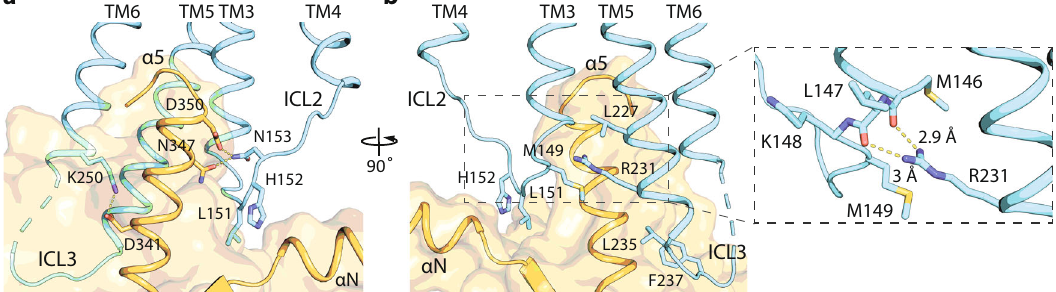
Fig. 7 Interactions between ICL2 of S1P 1 and G α i . a L151 in ICL2 is inserted into the hydrophobic pocket at the end of the N-terminal helix of G α i , and N153 forms hydrogen bonds with D350 and N347 from the α 5 helix of G α i . b L235 and F237 in ICL3 contact the hydrophobic surface of G α i , and K250 forms a salt bridge with D341 from the α 5 helix of G α i . R321 located at TM5 stretches to the amino-end of TM3 helix and interacts with the carbonyl backbone through hydrogen